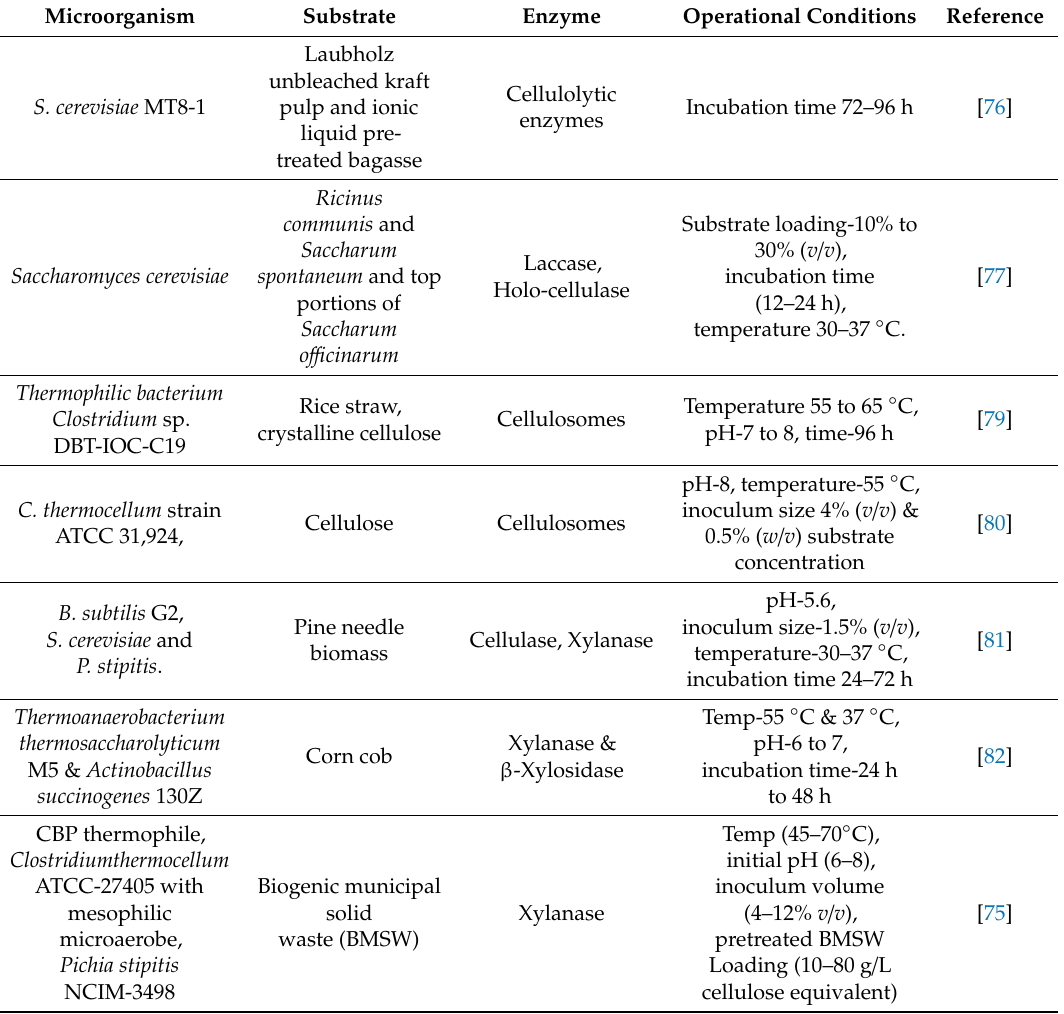
Figure 2. Schematic representation of consolidated bioprocessing processing in terms of biorefinery from lignocellulosic biomass. Table 2. Consolidated bioprocessing (CBP) for a mixture of lignocellulosic material in the enzyme production.